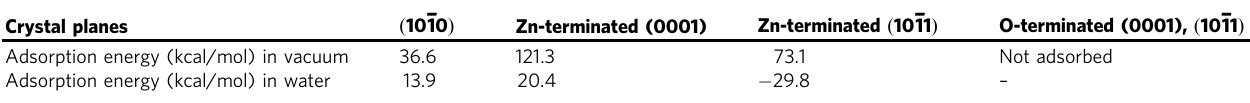
Table 2 Calculated adsorption energy of WO 4 2 − ion on ZnO ð 10 conditions.